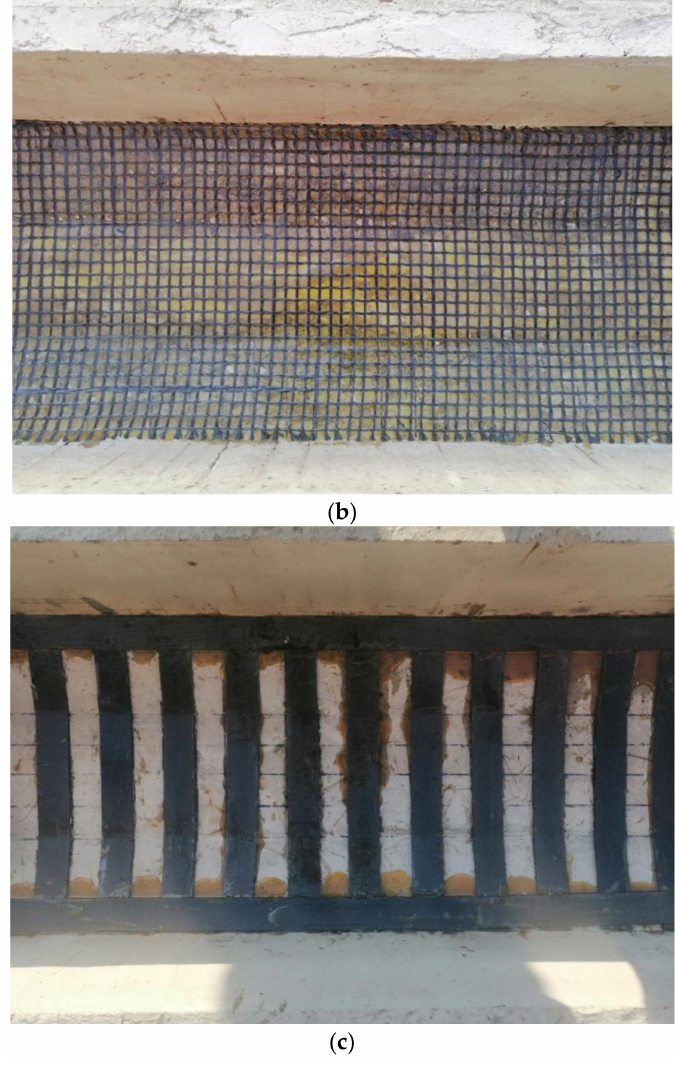
Figure 5. Reinforced test beam ( a ) CFRP cloth reinforcement, ( b ) CFRP mesh reinforcement, and ( c ) Strip plate